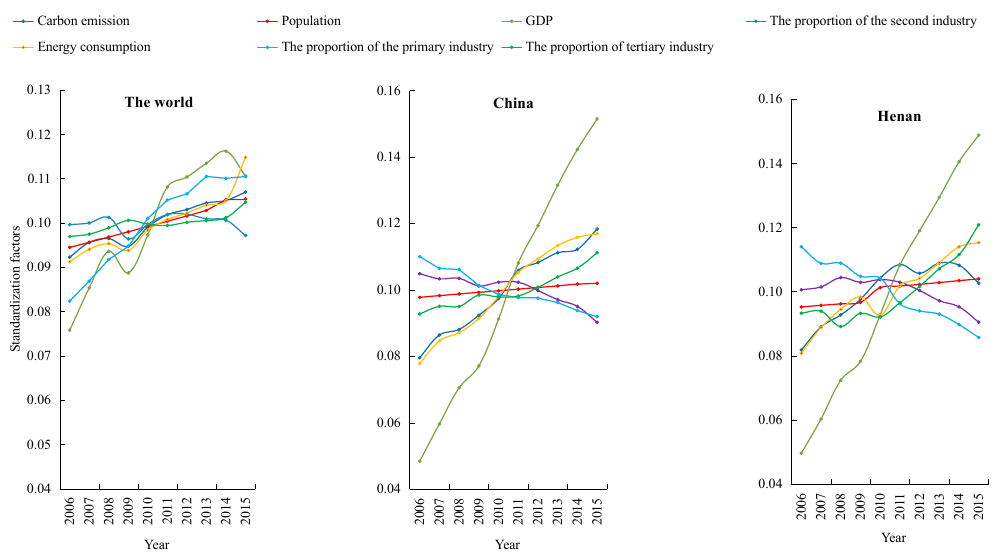
Figure 3. Variation of carbon emissions over time from three major economic sectors in Henan Province in comparison to China and the World during 2006–2015.